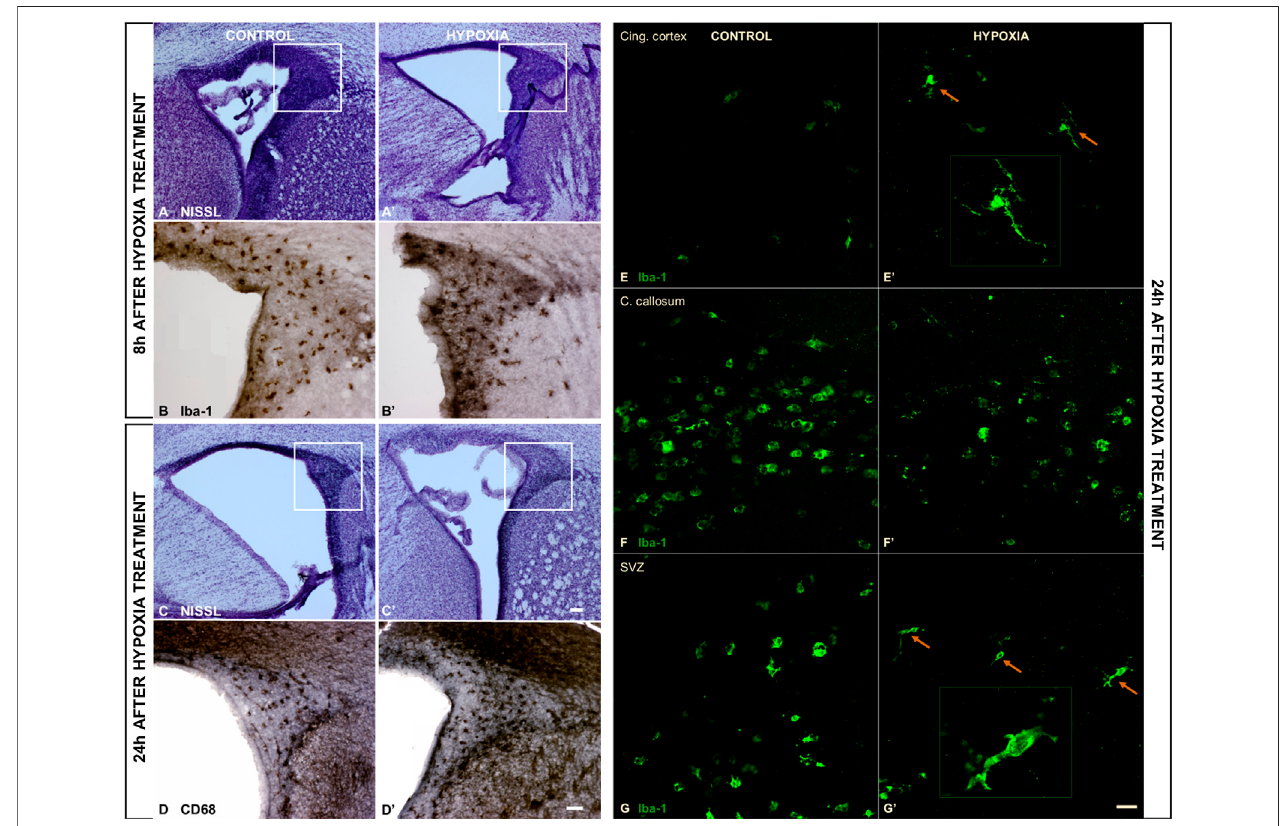
FIGURE3| Thecoronalsectionsofthesubventricularzone(SVZ)andmicroglialcellmorphologycon fi rmingtheaffectedproliferationpoolandlimitedmicroglialcell activationafter moderate perinatalhypoxia. (A,A ’ ,C,C ’ ) Show adistinctdecrease ofcell densityinthe proliferative SVZinhypoxia-treated animals compared tocontrols, at 8 h (A,A ’ ) and more pronounced at 24 h (C,C ’ ) after hypoxia. (B,B ’ ) The ionized-calcium-binding-adaptor-molecule-1 (Iba-1) staining 8 h after hypoxia shows less numerousbutmorerami fi edmicroglialcellsinSVZinhypoxia-treated animals. (D,D ’ ) TheclassDscavengerreceptor68(CD68)staining24 hafterhypoxia reveals no severe macrophage reactivity in hypoxia-treated animals compared to controls. (E – G ’ ) Display a change in morphology of Iba-1-immunoreactive microglia in the cingulate cortex and SVZ, but not in the corpus callosum. Control animals ’ cingulate cortex and SVZ contained intermediate microglia (E,G), while in hypoxia-treated animals, microglia developed a rami fi ed morphology [ (E ’ ,G ’ ) arrows], suggesting their precocious maturation. (F,F ’ ) Within the corpus callosum, these cells have the same amoeboid morphology in both groups of animals. The actual image magni fi cation for (A,A ’ ,C,C ’ ) is shown with the scale bar in (C ’ ) , presenting 100 µm, for (B,B ’ ,D,D ’ ) is shown in (D) presenting 50 µm, and for (E – G ’ ) scale bar is in (G ’ ) presenting 25 µm.